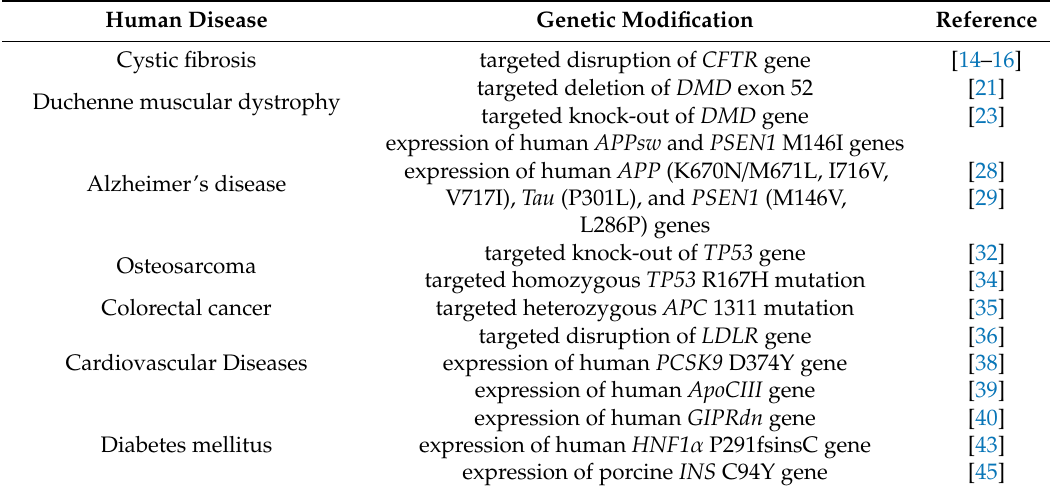
Table 2. Selected genetically engineered pig models for human